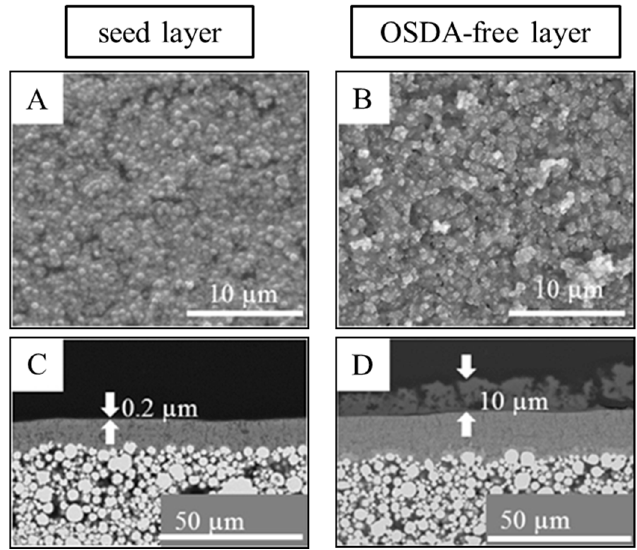
Figure 2. SEM (top view and cross section) of the experimental series 3: layer after the seeding step (membrane number 3.1—( A , C )), and after the OSDA-free secondary growth step (membrane number 3.2—( B , D )). The overall layer thickness of about 10 µm is a zeolite beta layer, which is divided into two sections: a very thin, denser zeolite beta base layer of about 1 µm (not marked) and a porous and loosely packed, thicker part.